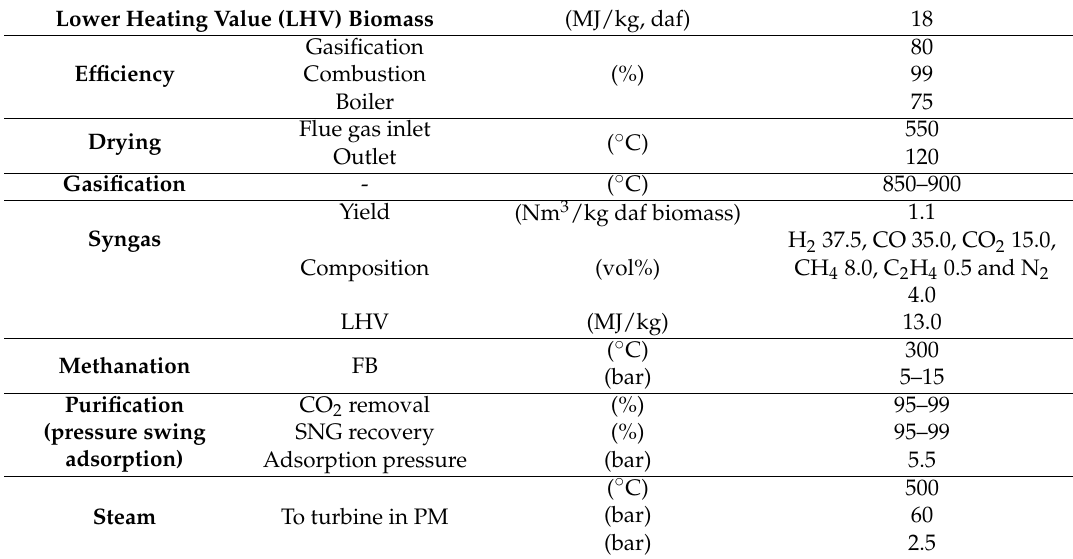
Table 2. Model input data